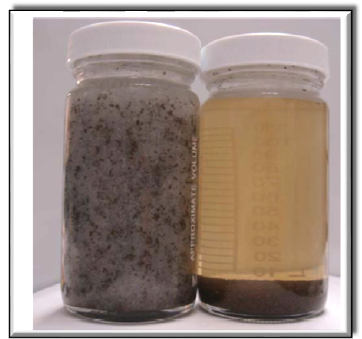
Figure 6. Sand suspension test’s solutions.